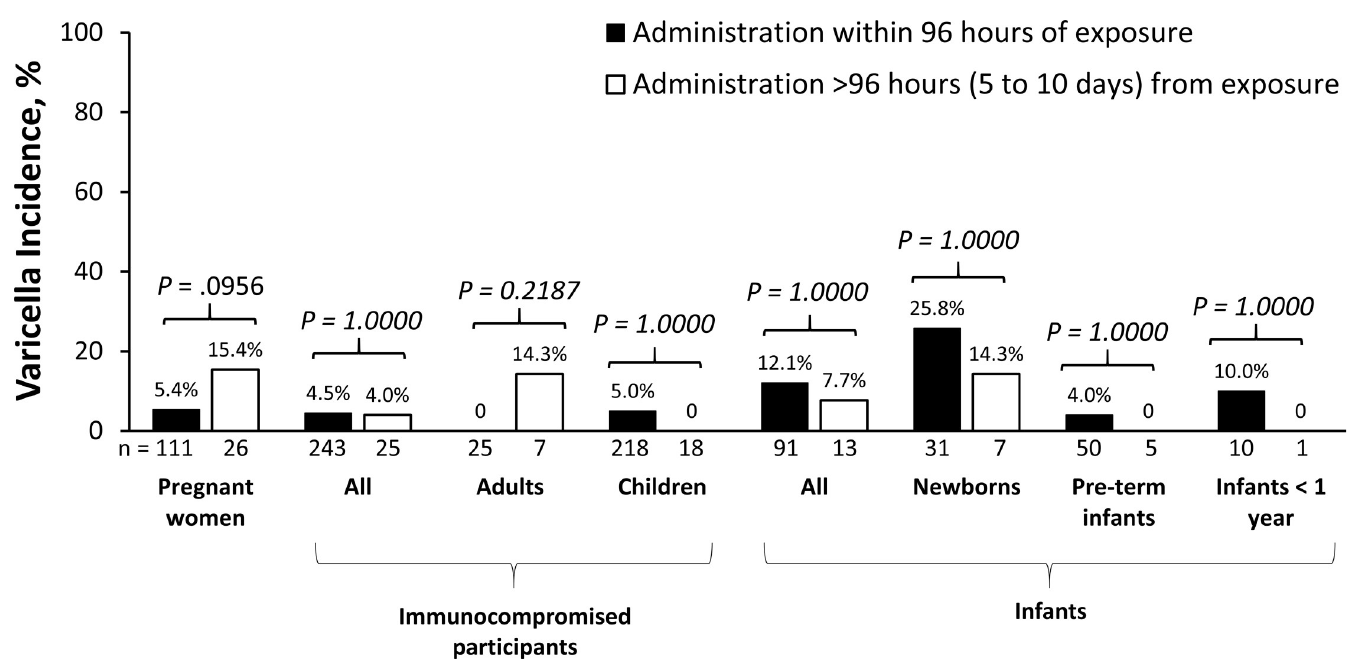
Fig 3. Incidence of varicella by timing of administration. P values were determined using a 2-sided Fisher’s exact test. CI confidence interval.